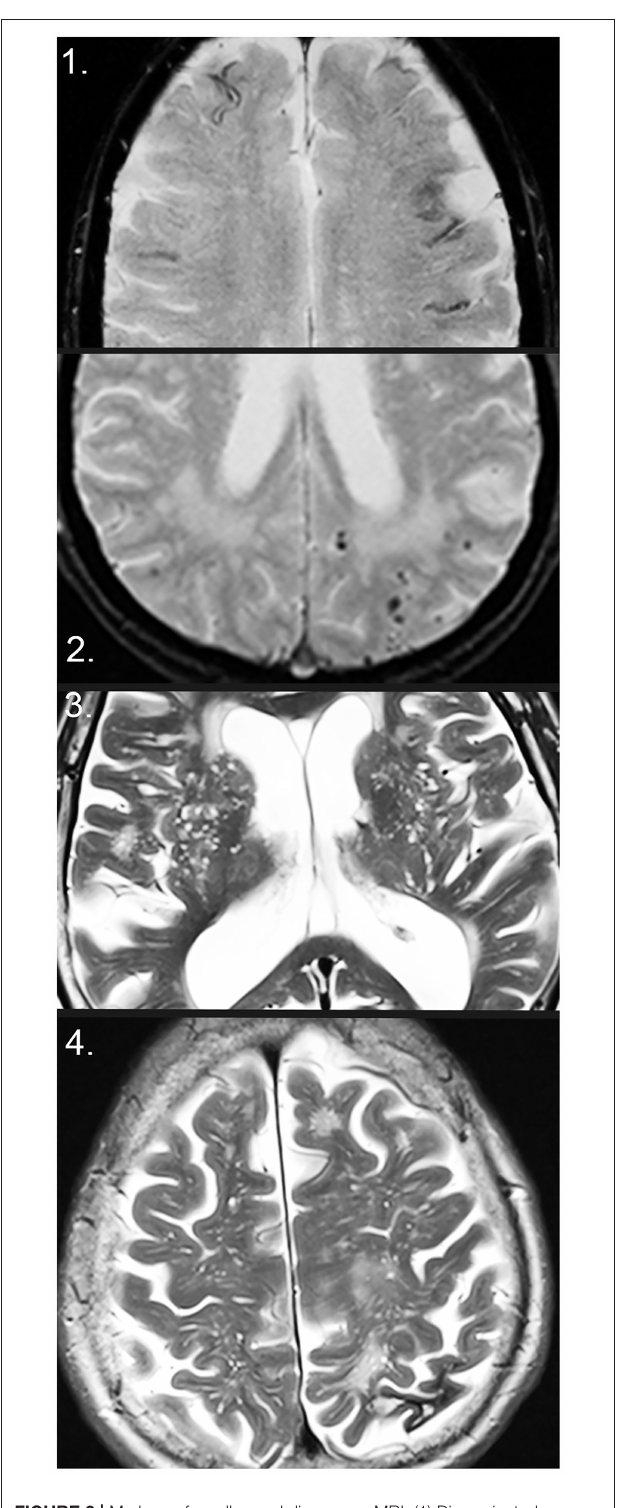
FIGURE 2 | Markers of small vessel disease on MRI. (1) Disseminated superficial siderosis on T2*. (2) Cerebral microbleeds (CMBs), as well as white matter hyperintensities on T2*. (3) Enlarged perivascular spaces (EPVS) in the basal ganglia on T2. (4) EPVS in the centrum semiovale on T2 and intracerebral macrohemorrhage with local atrophy in the left parietal